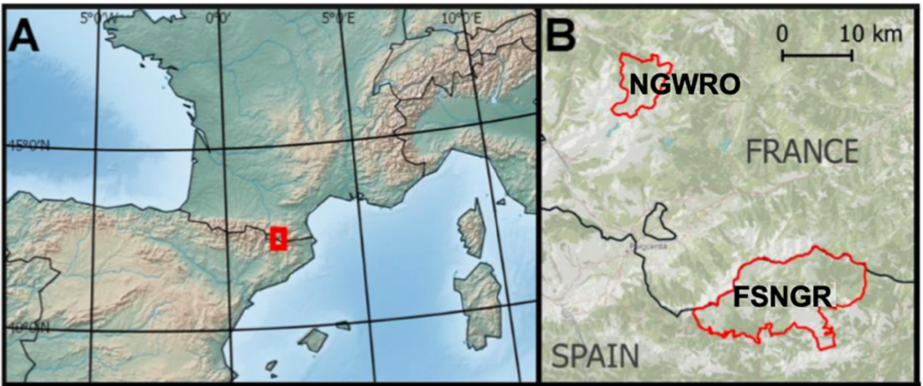
Figure 1. The two study areas. ( A ) Map of south-western Europe with the location of our study areas noted with a red rectangle. ( B ) Zoom in on the previous red rectangle with the location of the National Game and Wildlife Reserve of Orlu (NGWRO) in France and the Freser-Setcases National Game Reserve (FSNGR) in Spain (both delimitated by a red line). Thick black line represents France–Spain